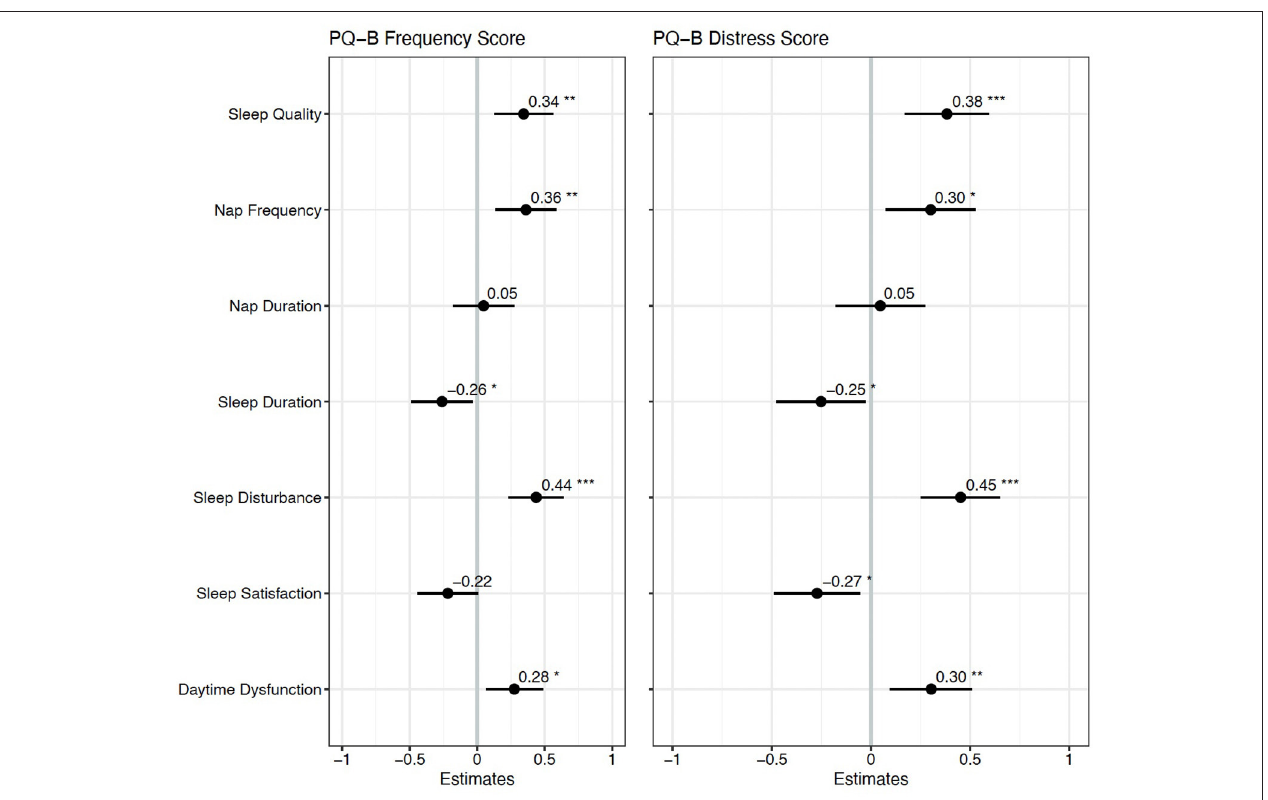
FIGURE 2 | Standardized regression coefficients for each sleep predictor of PQ-B frequency and distress scores. *Indicates p < 0.05, **Indicates p < 0.01 and ***Indicates p < 0.001. Higher frequency and distress scores on the PQ-B were associated with worse sleep quality, more frequent naps, shorter sleep duration, and greater sleep disturbance and daytime dysfunction.